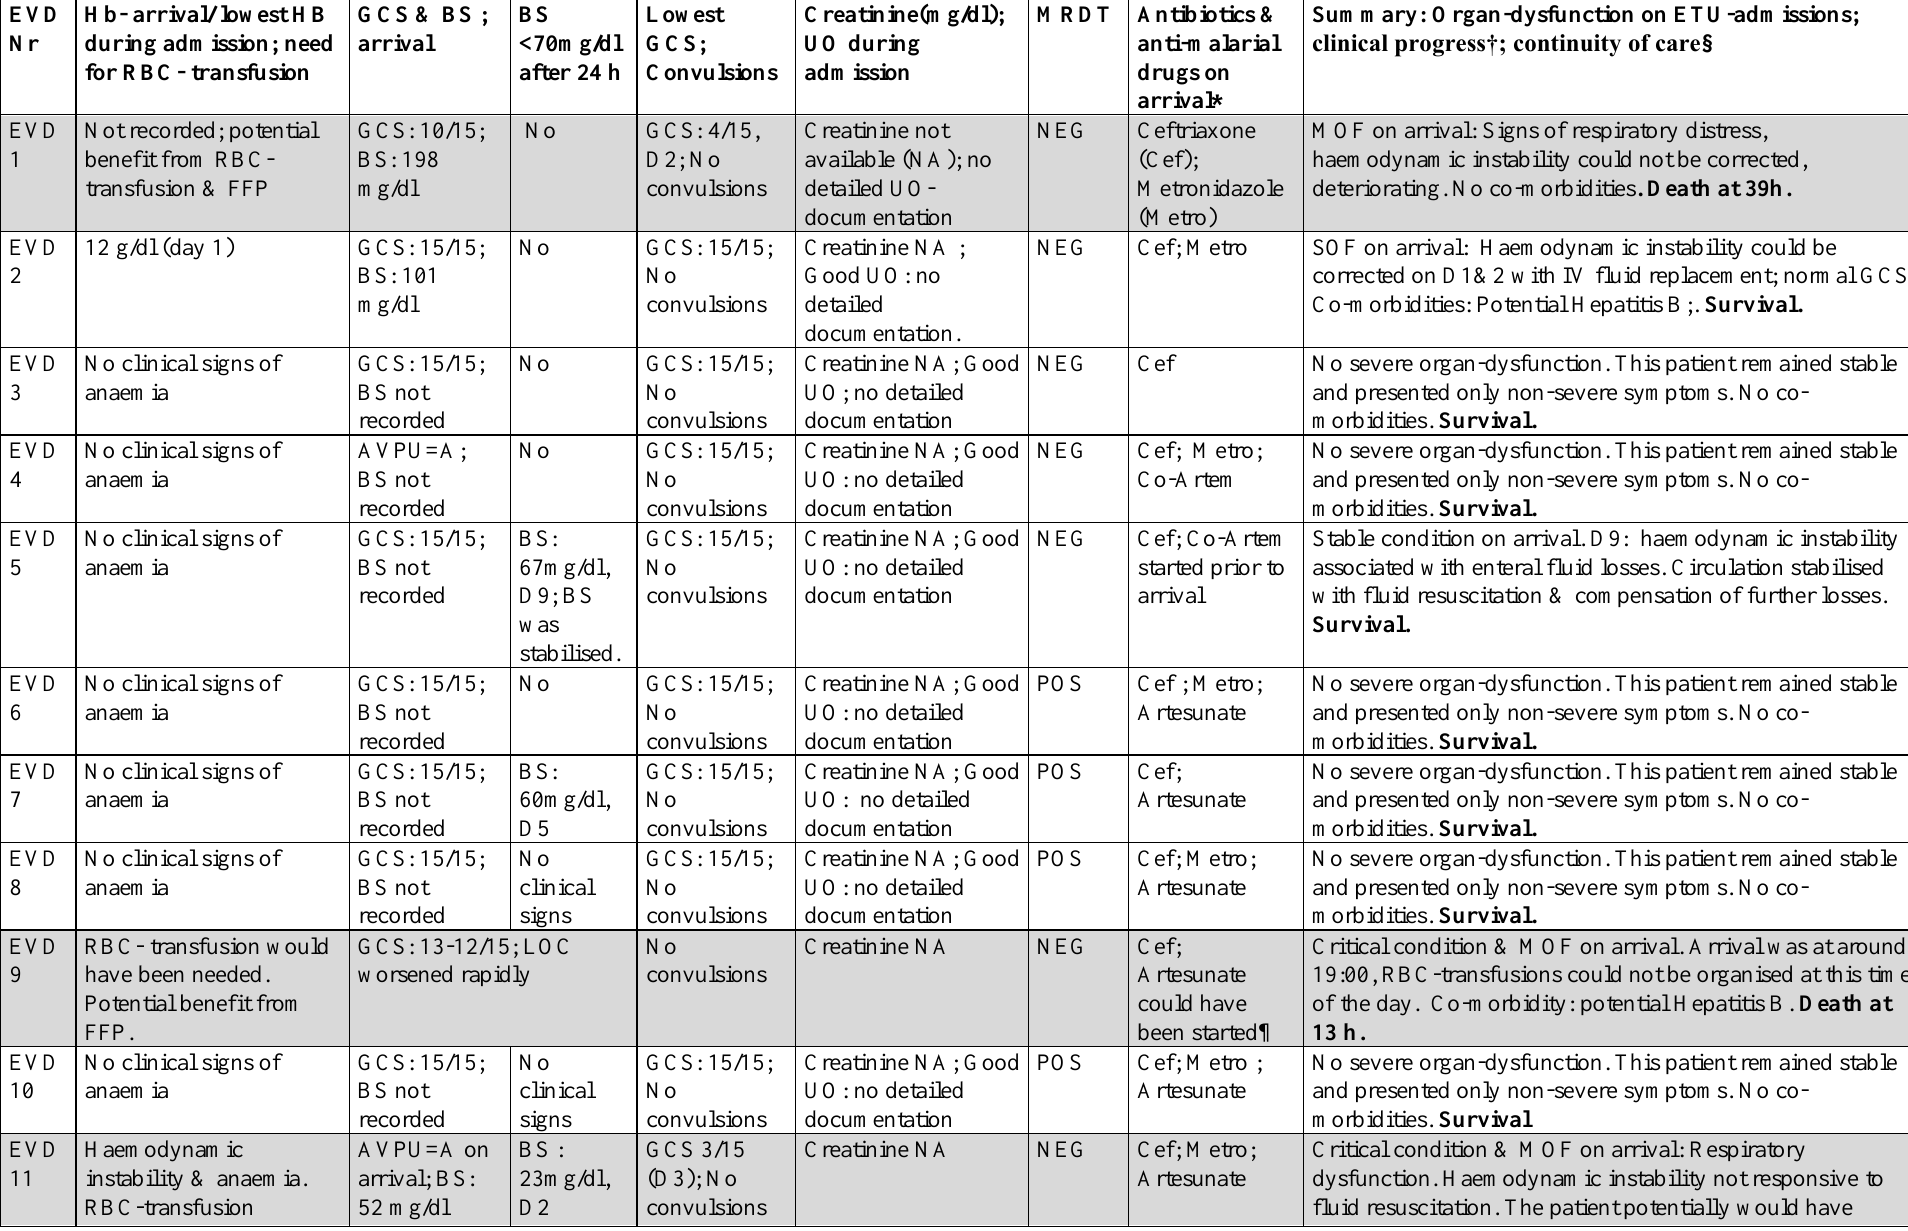
Table 1 B: Further information on the 13 EVD-patients and one patient with Lassa virus disease (LVD) 43 including: clinical presentation and organ function, clinical outcomes. Abbreviations: seen end of the